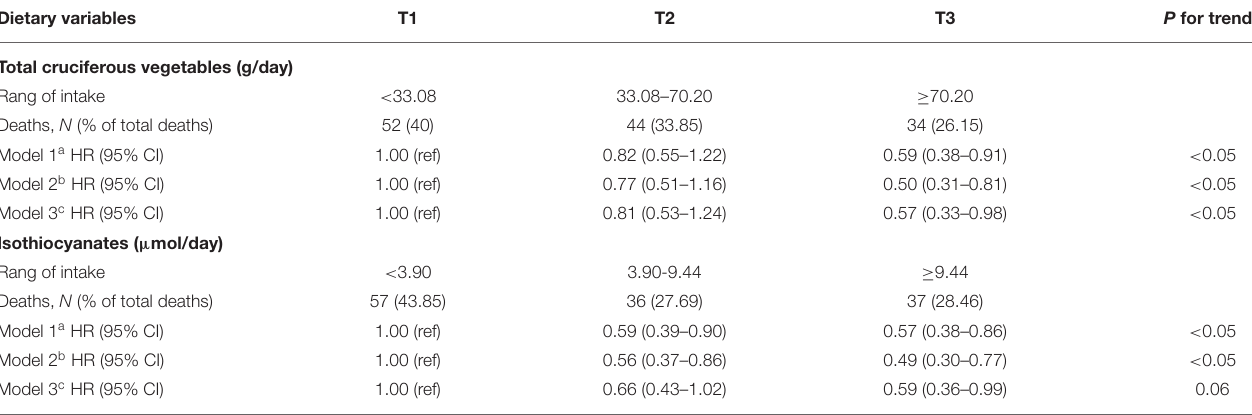
TABLE 3 | Hazard ratio (95% CI) for overall survival among ovarian cancer patients according to cruciferous vegetables and relative nutrient intake. Dietary variables T1 T2 T3 P for trend d